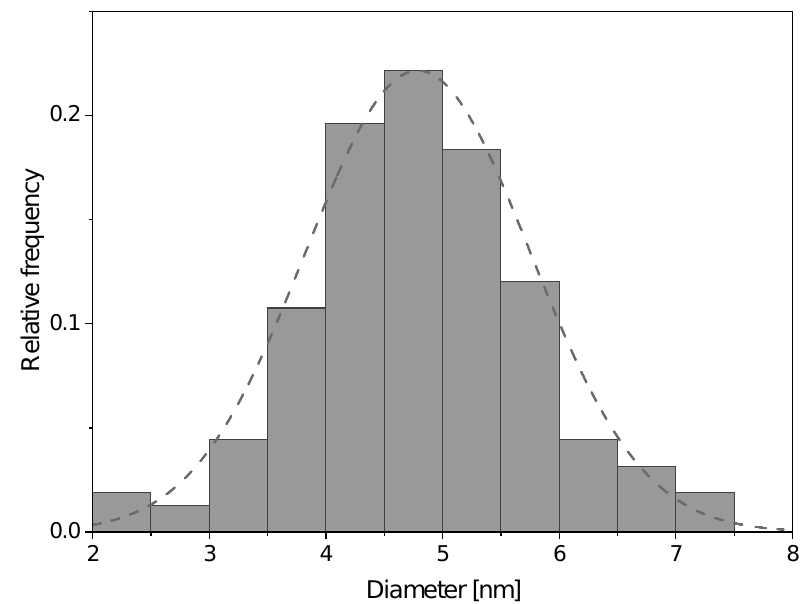
Figure 2. Nanoparticle size distribution for all doses. The dashed line shows a normal distribution fit ( (cid:104) d (cid:105) = 4.8nm, σ =